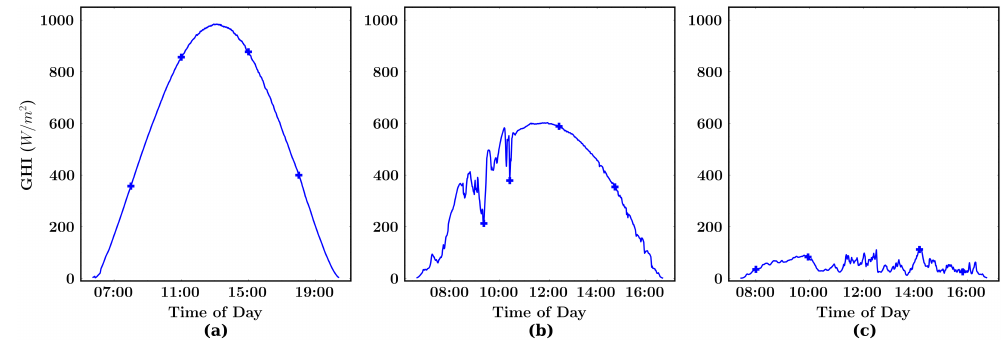
Figure 2. Daily GHI plots for the days ( a ) 7 June 2014, ( b ) 3 November 2014, and ( c ) 24 December 2014.